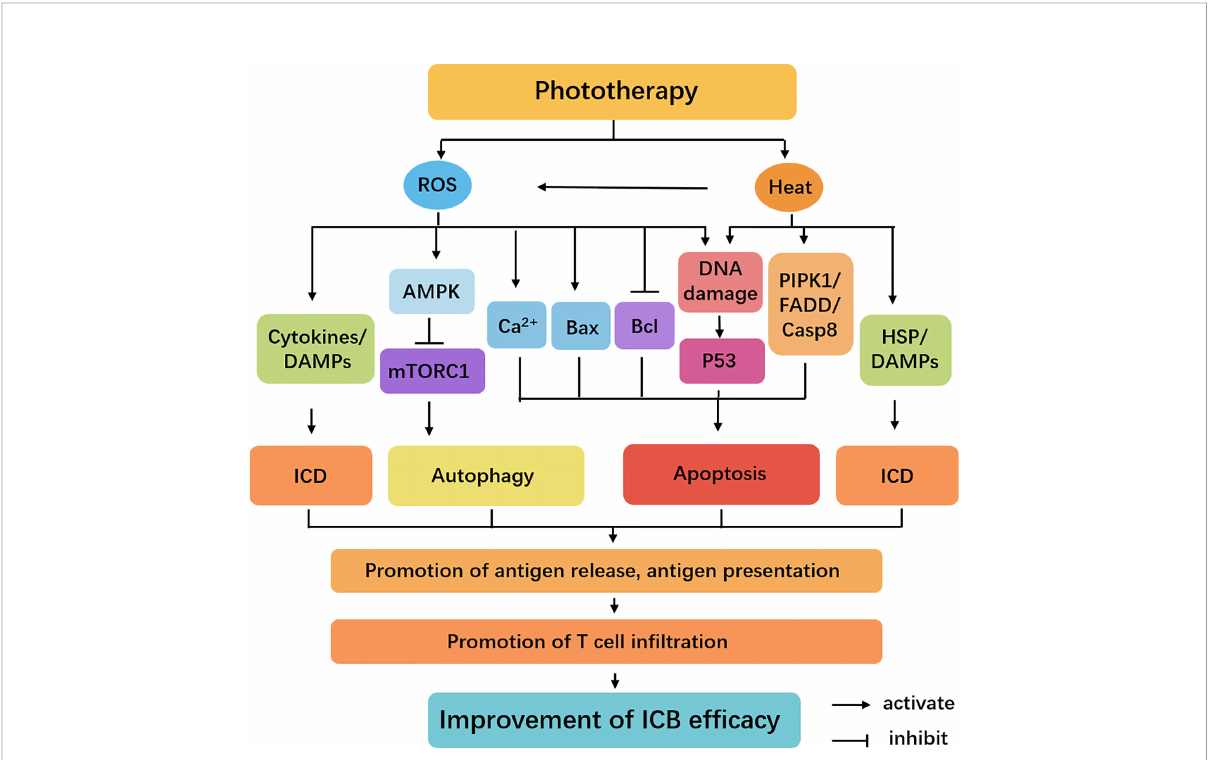
FIGURE 4 Cellular signaling pathways regulated by phototherapy and ICB. The irradiation triggers the activation of heat and ROS-mediated AMPK, Bax, Bcl, p53, and RIPK1 signaling. These pathways have different roles in the induction of apoptotic cell death and protective autophagy. Meanwhile, several DAMPs and cytokines play important roles in ICD. These dead cancer cells release antigens, promoting the tumor antigen processing and presentation and T cell in fi ltration to improve the ef fi ciency of